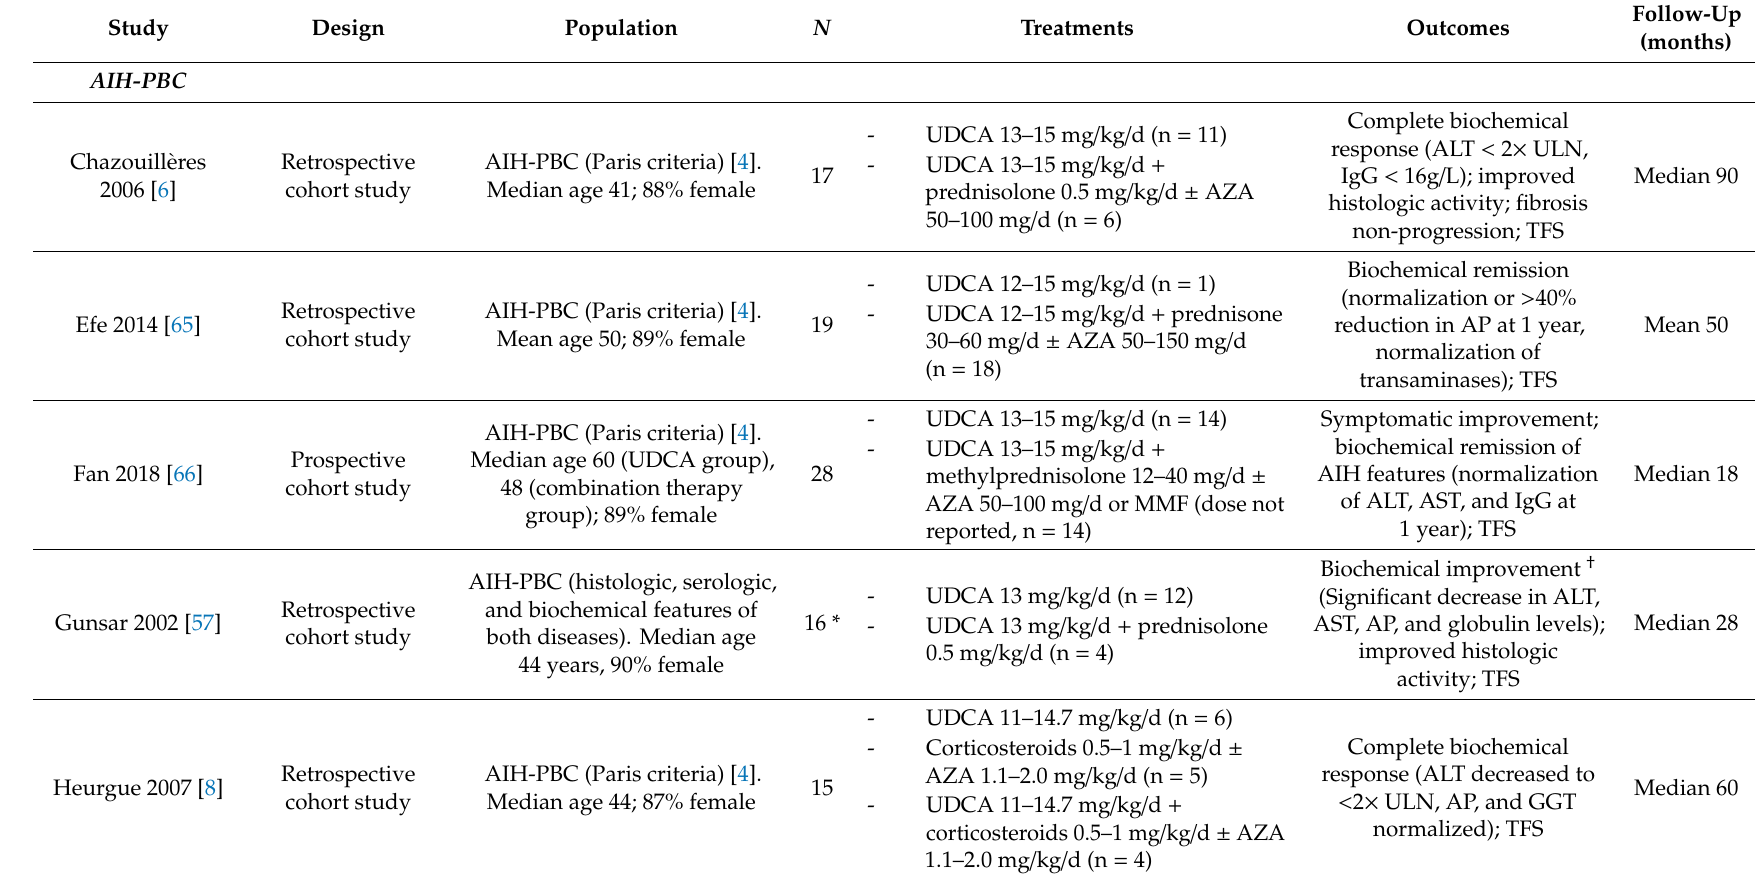
Table 1. Studies included in systematic